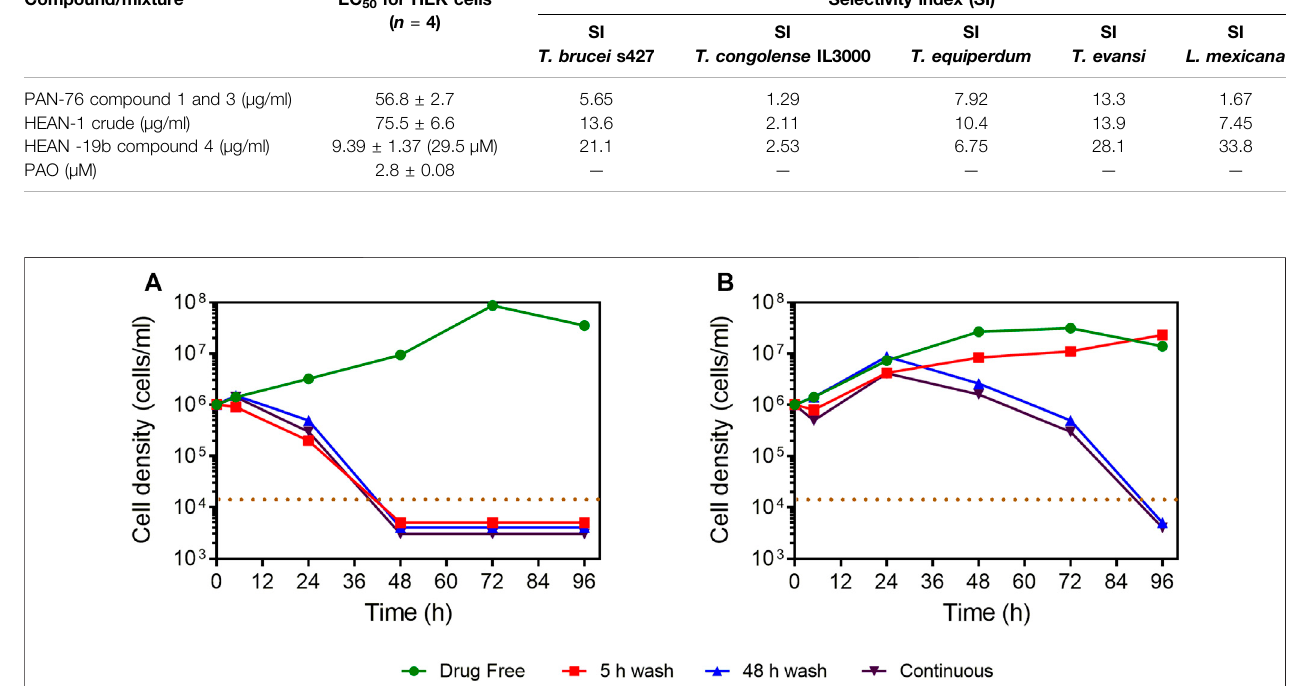
FIGURE3| Manual cellcount of L. mexicana cultures grown in thepresence or absenceofcompound 4 andpentamidineat 5 × EC 50 ,withor without washafter 5 or 48 h of incubation. (A) Compound 4 . (B) Pentamidine. The dotted brown line indicates the detection limit, being 10 4 cells/ml. For convenience, where no cells were observed in the counting chamber, the values of 5,000, 4,000, or 3,000 cells/ml were entered to facilitate a graphical representation.